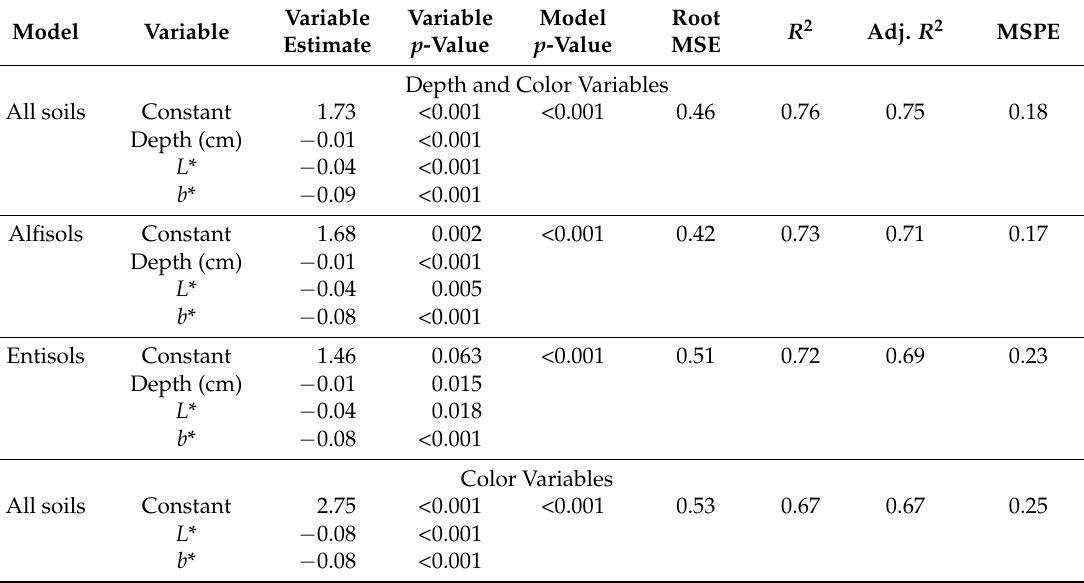
Table 4. Variable estimates and ANOVA results for final prediction models using depth (cm) and color variables, and color variables alone, to predict lnTN